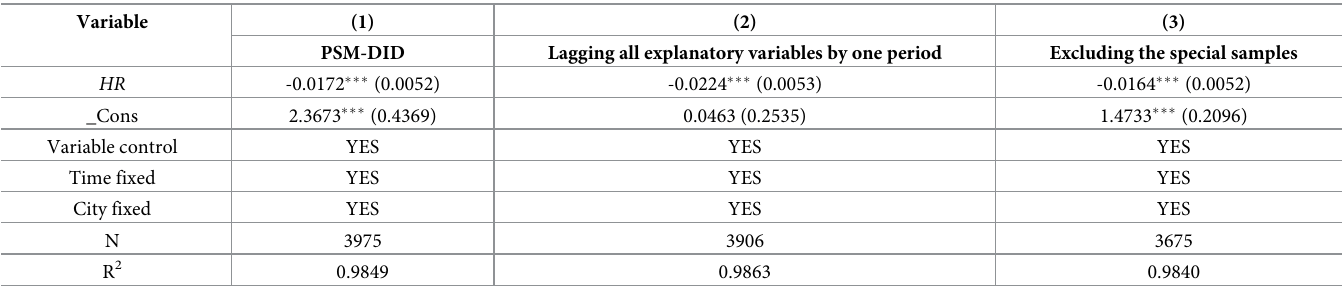
Table 5. Robustness